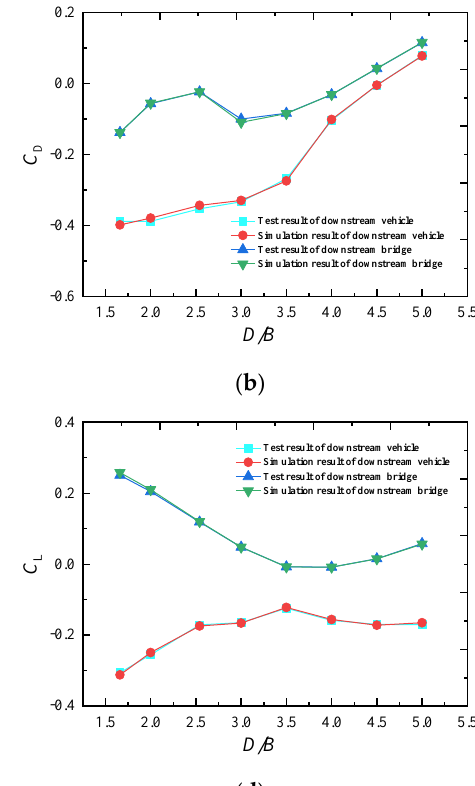
Figure 27. Computational domain and boundary conditions (units: mm).